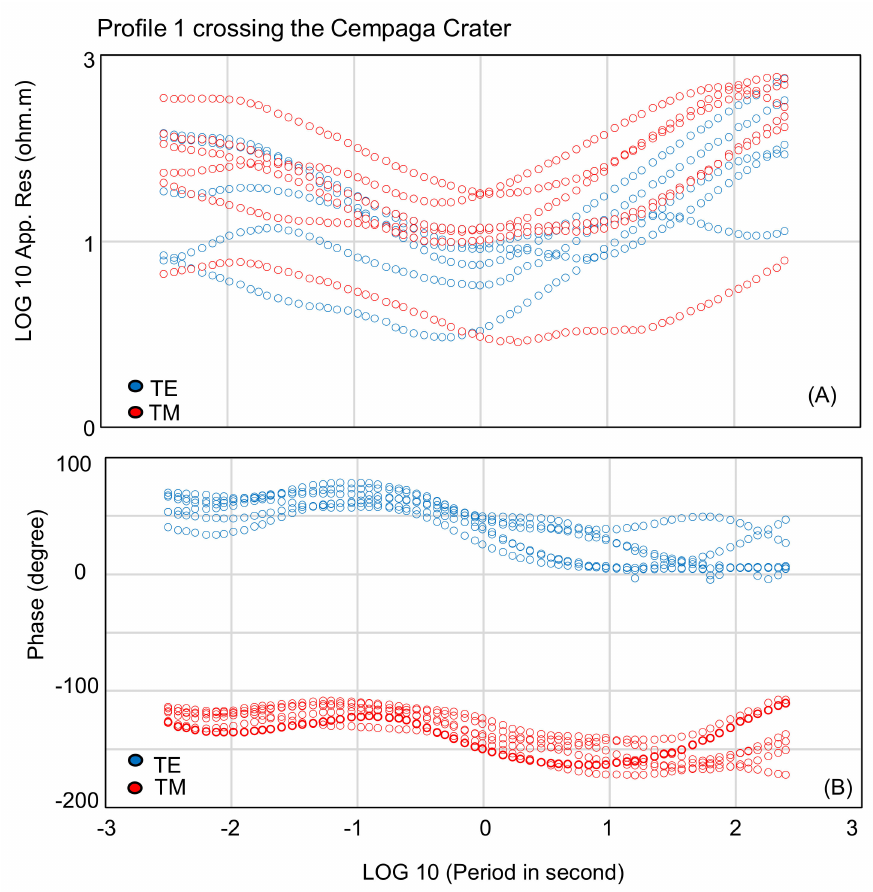
Figure 6. Examples of the observed MT data in Profile 1 with six stations crossing the Cempaga crater of the volcano: ( A ) data on apparent resistivities (ohm · m) and ( B ) impedance phases (degree) as a function of log 10 periods (s). The red represents the TM mode, while the blue represents the TE